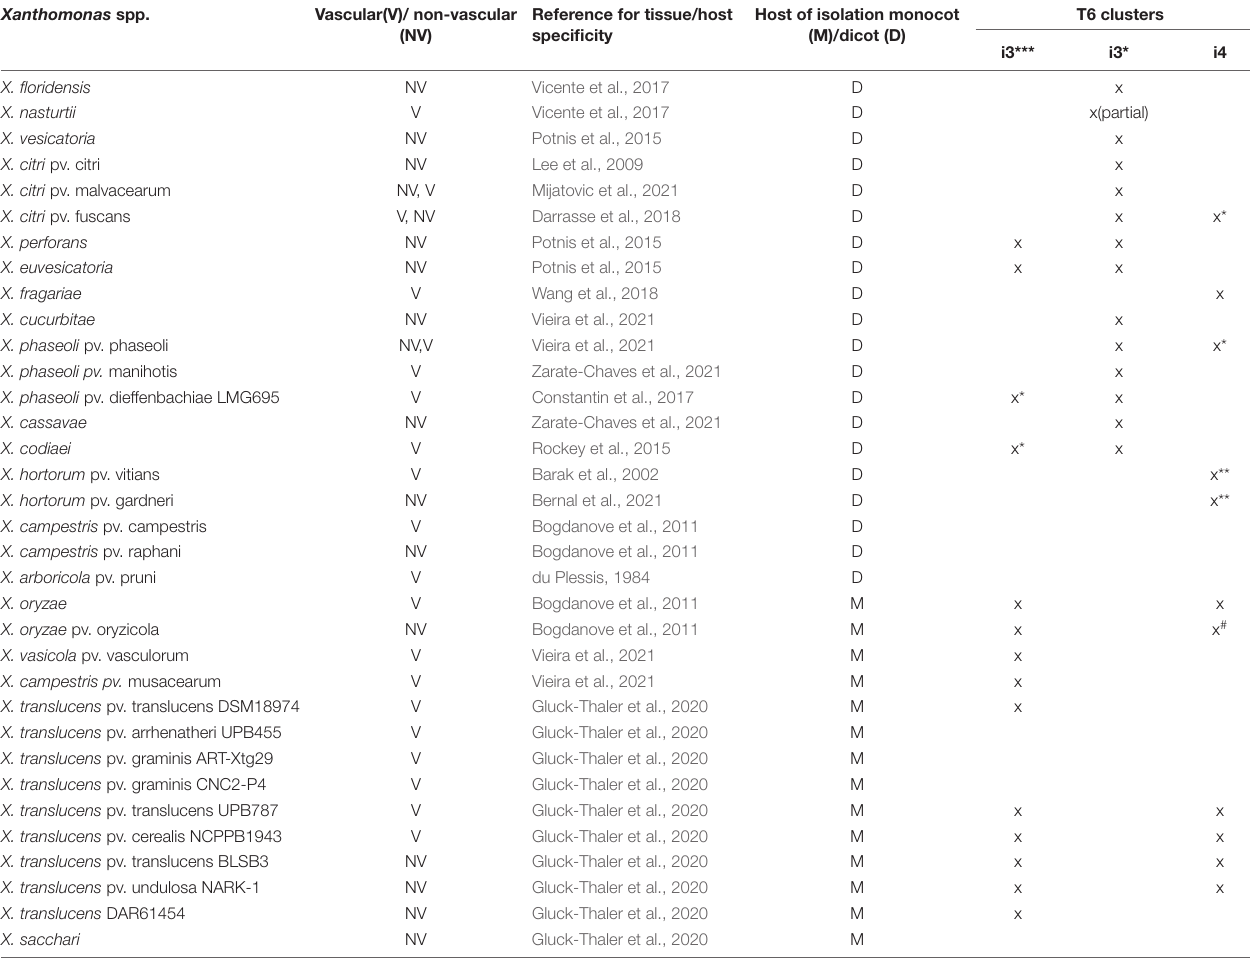
TABLE 3 | Distribution of the T6 clusters according to the lifestyle of Xanthomonas spp. Xanthomonas